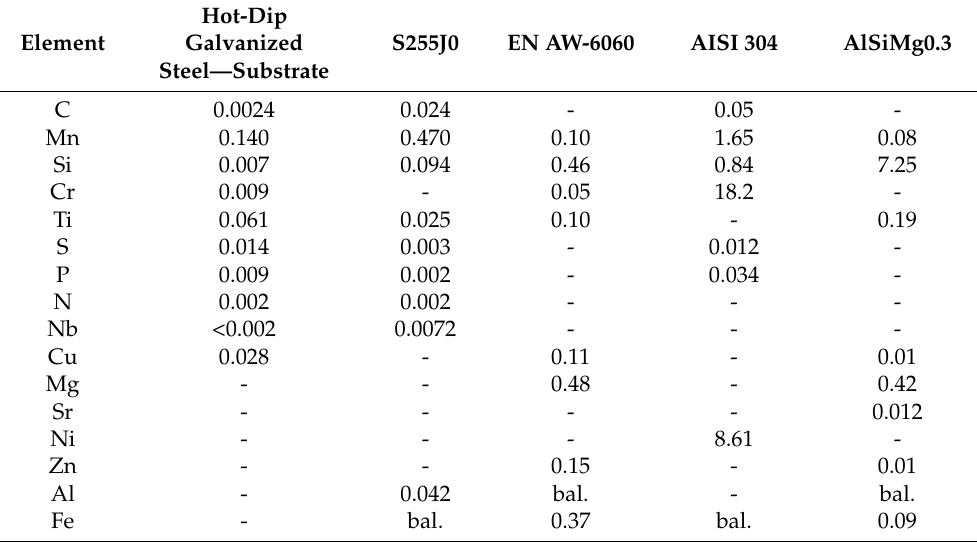
Table 1. Chemical composition of used materials (in wt %).